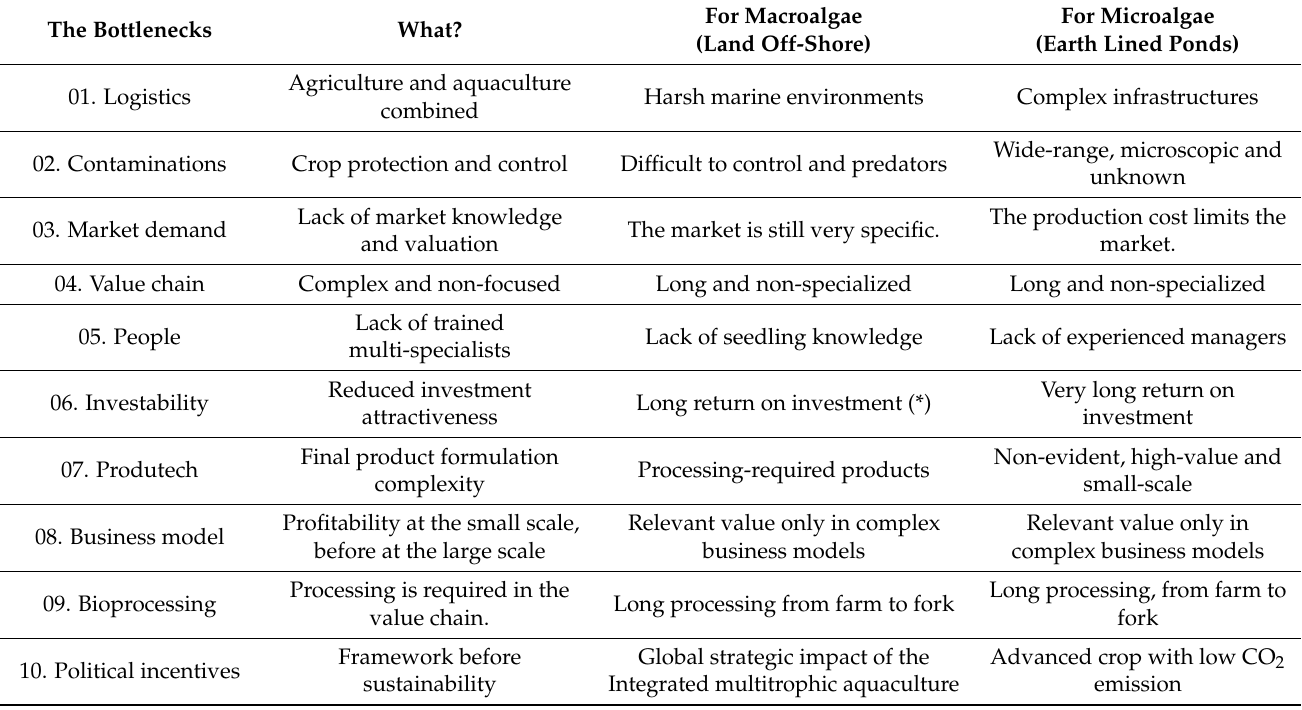
Table 2. Most relevant bottlenecks for both macro- and